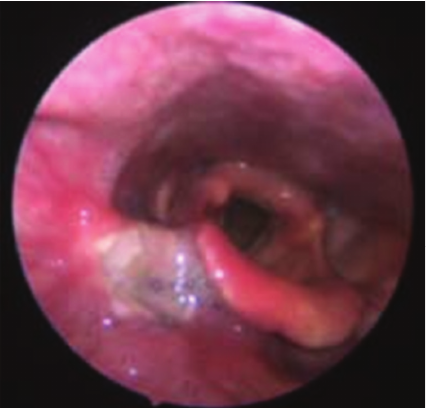
Figure 1: Endoscopic view evidences an ulcerative lesion on the right pharyngoepiglottic ligament, homolateral vallecula, and the right pyriform sinus.